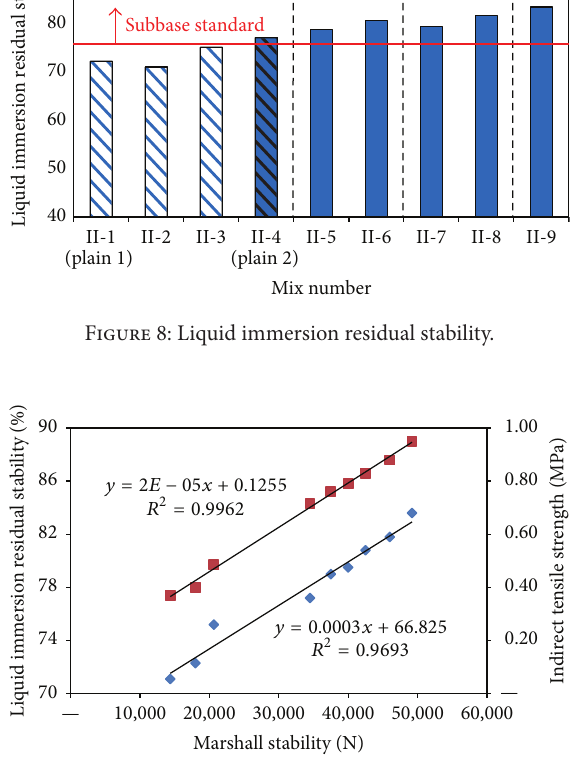
Figure 9: Correlation between Marshall stability, indirect tensile strength, and liquid immersion residual stability.